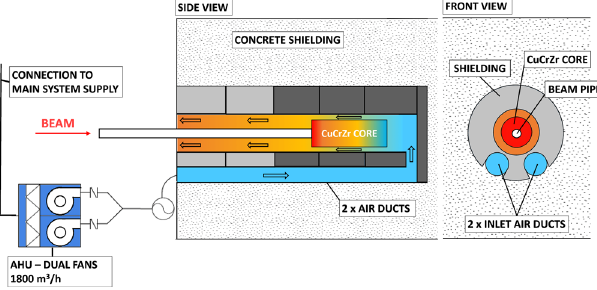
FIG. 7. Simplified plan of the cooling system of the new PSB dump, showing the different components that are part of the system.